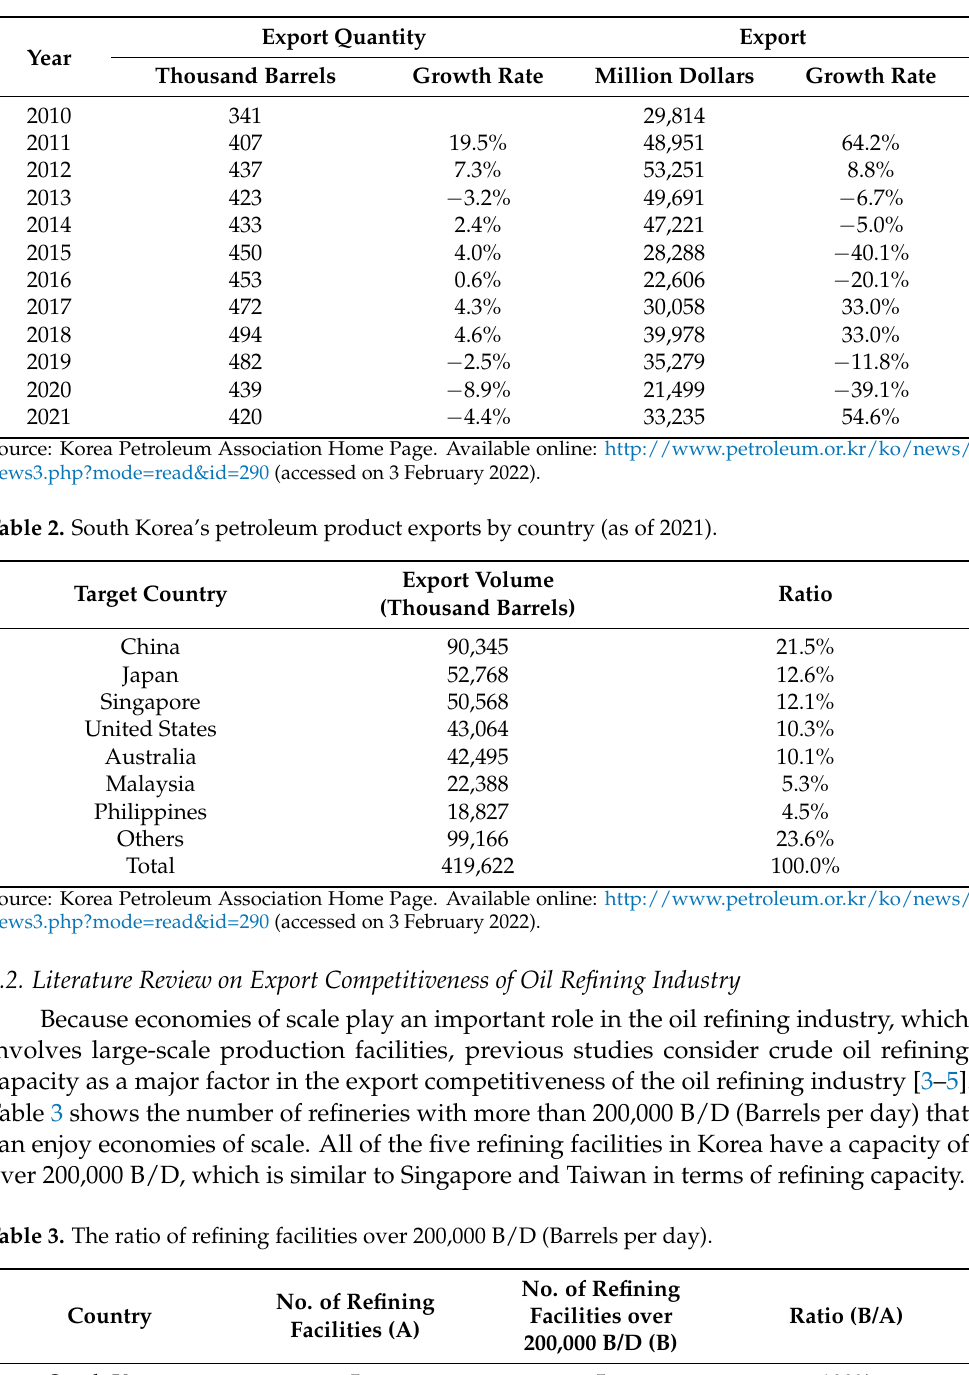
Table 1. Export statistics of South Korean refining industry.